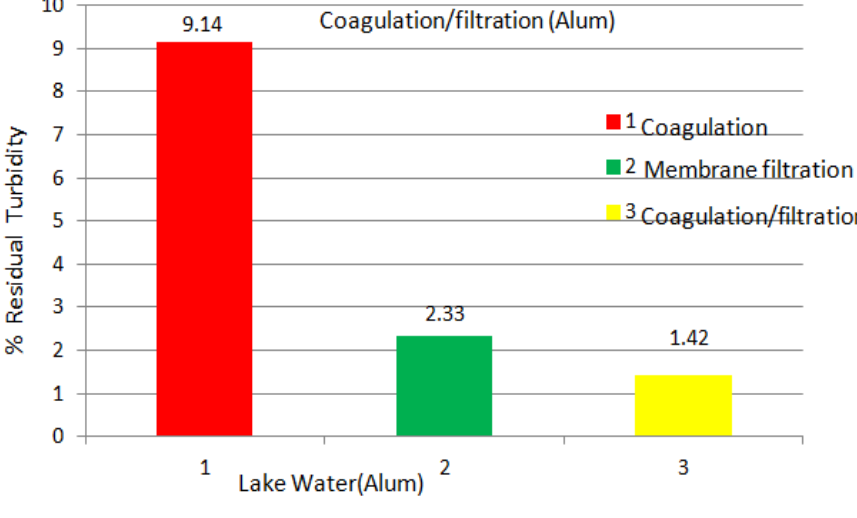
1 h of settlement in